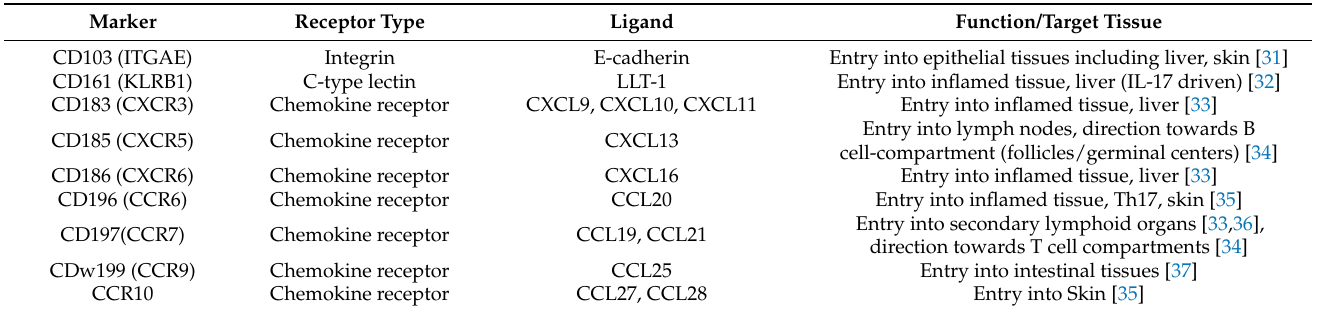
Table 1. Flow cytometric panel for the identification of homing receptors expressed by antigen-specific lymphocyte population.